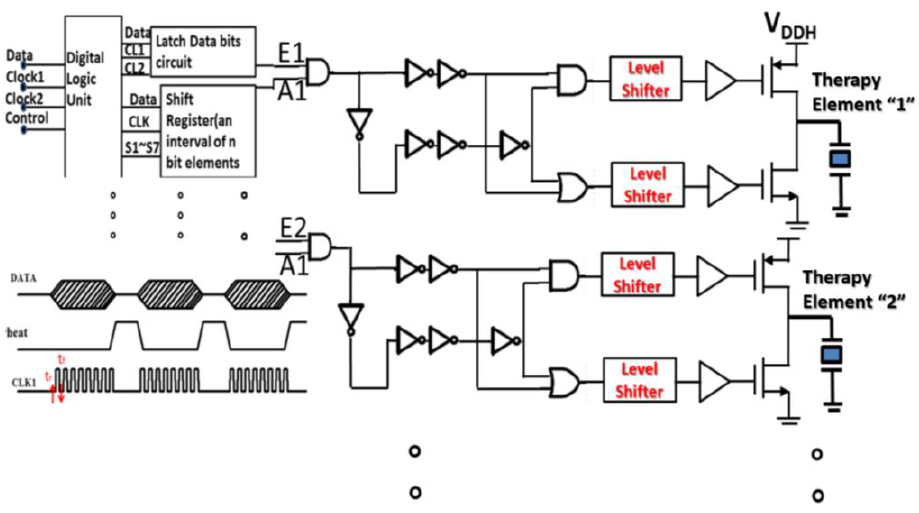
Figure 2. Far-infrared logic operation control system.